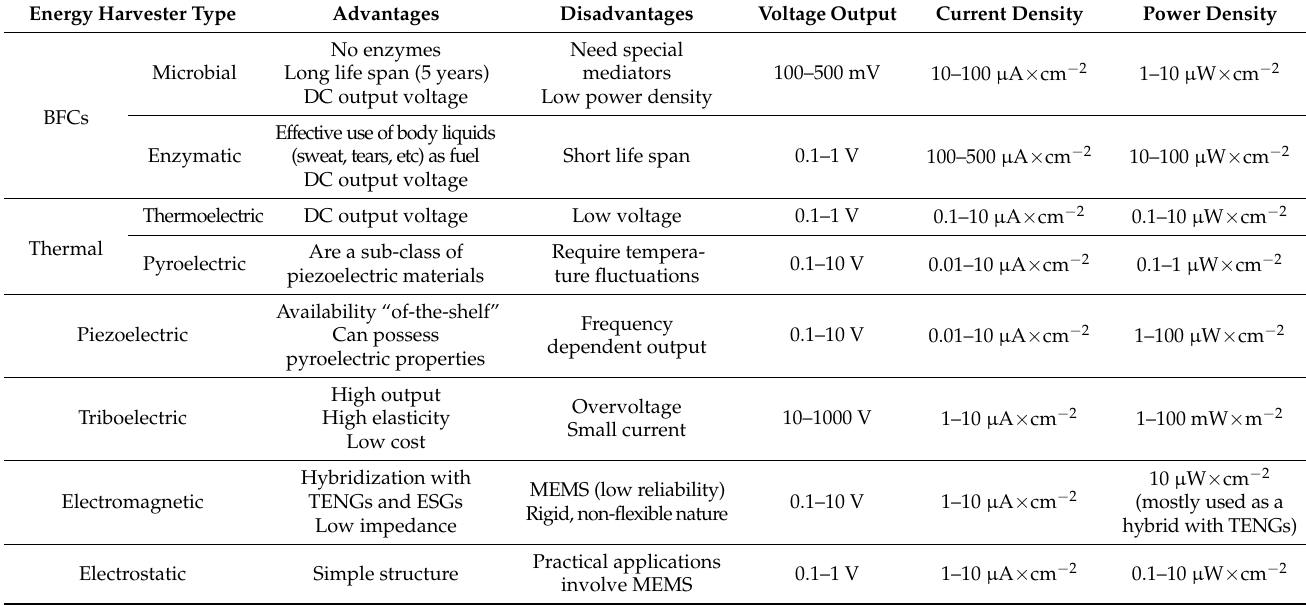
Table 2. Advantages and disadvantages of various types of